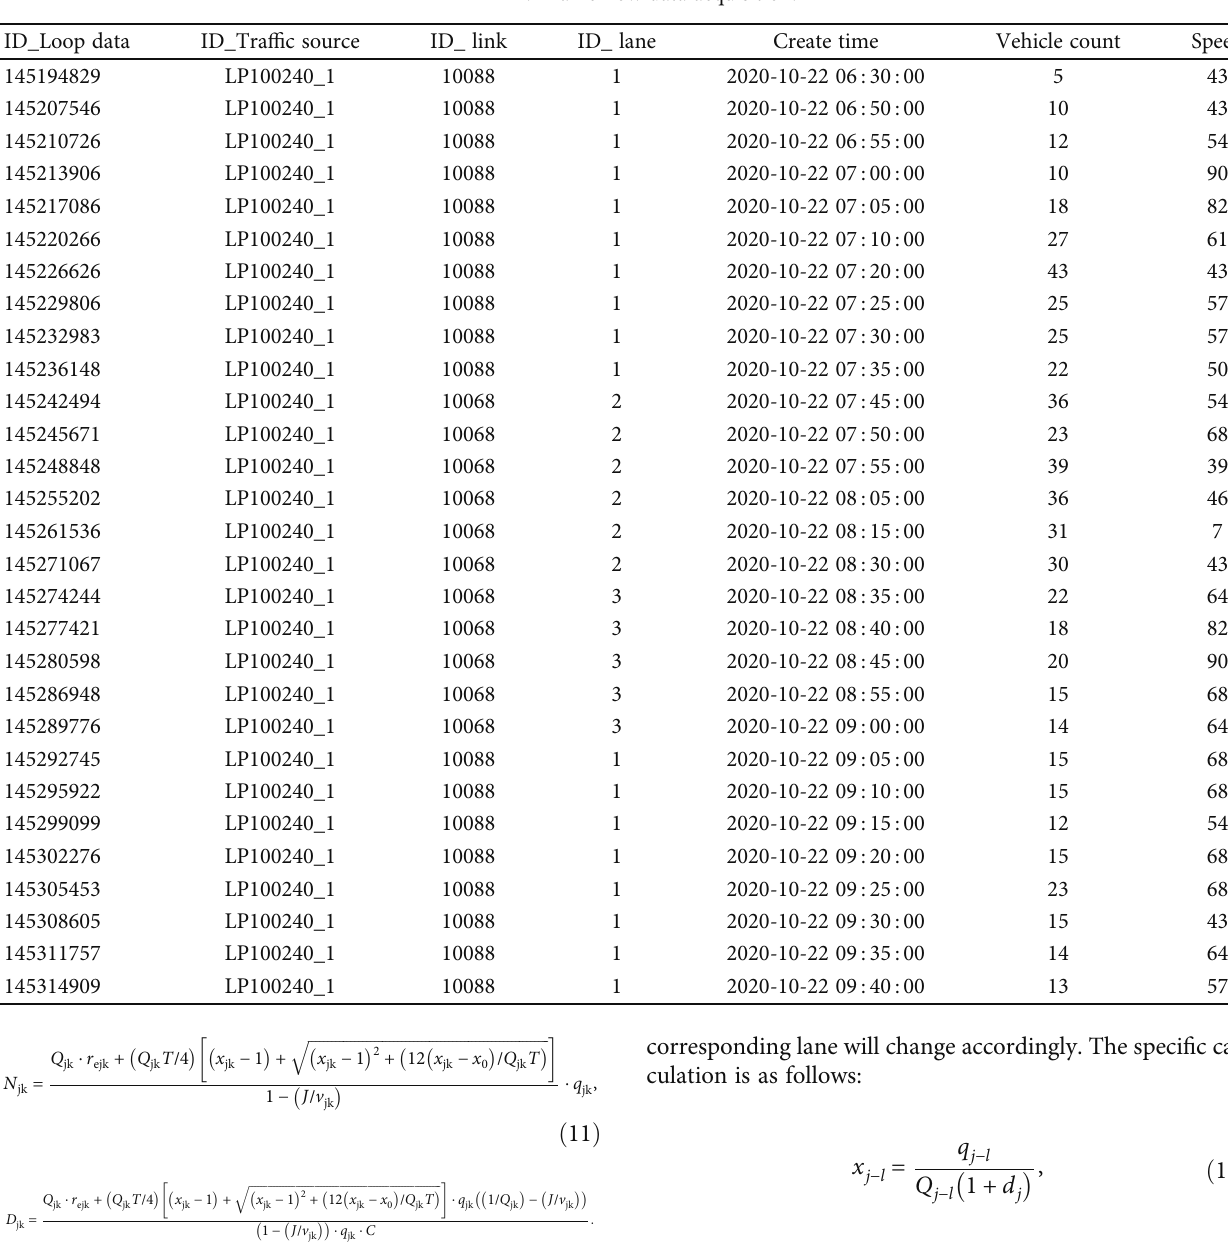
Table 2: Tra ffi c fl ow data